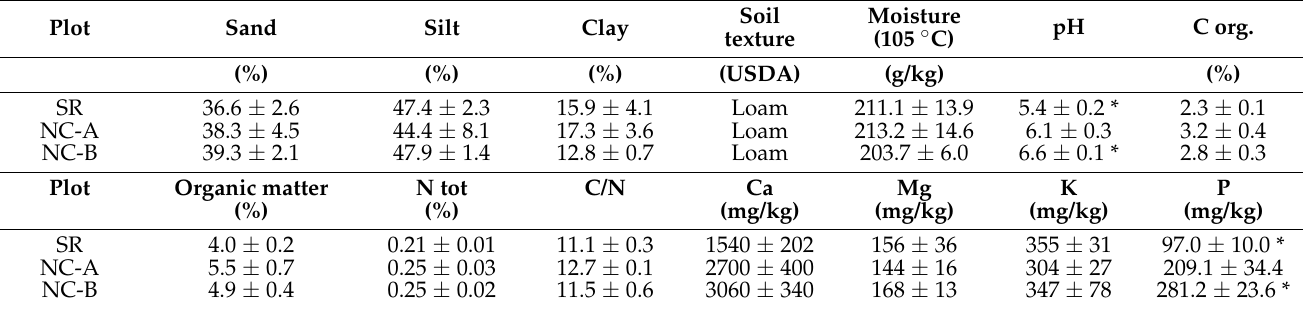
Table 1. Chemical analysis of soil samples taken from Sorac á (SR) and Nuevo Col ó n (steep slope plot at higher altitude: NC-A; flat plot at lower altitude: NC-B). pear orchards (mean values ± standard deviation). * Significant at 0.05 probability level ( p < 0.05), Kruskal–Wallis test with Bonferroni correction for multiple comparisons. Plot